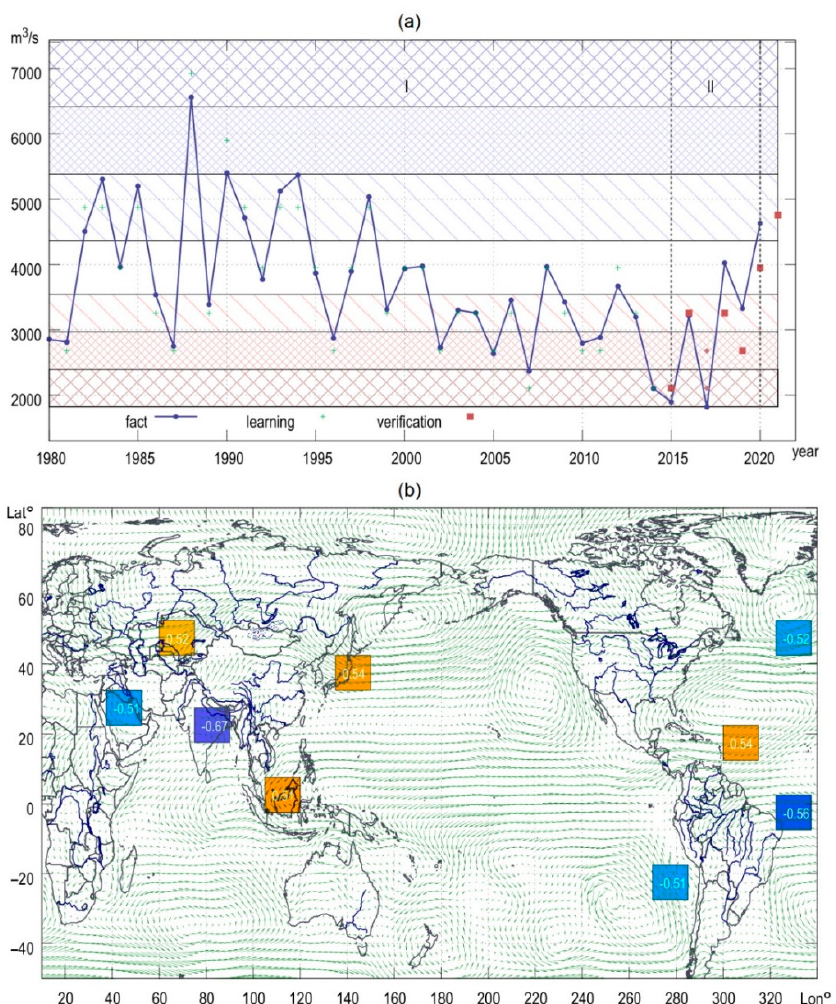
Figure 4. An example of: ( a ) building the predictive interval estimates of the effective inflow to Lake Baikal with the help of MNN; ( b ) based on the identification of potential predictors by the vorticity indices for the 850 hPa atmosphere layer in February 2021.